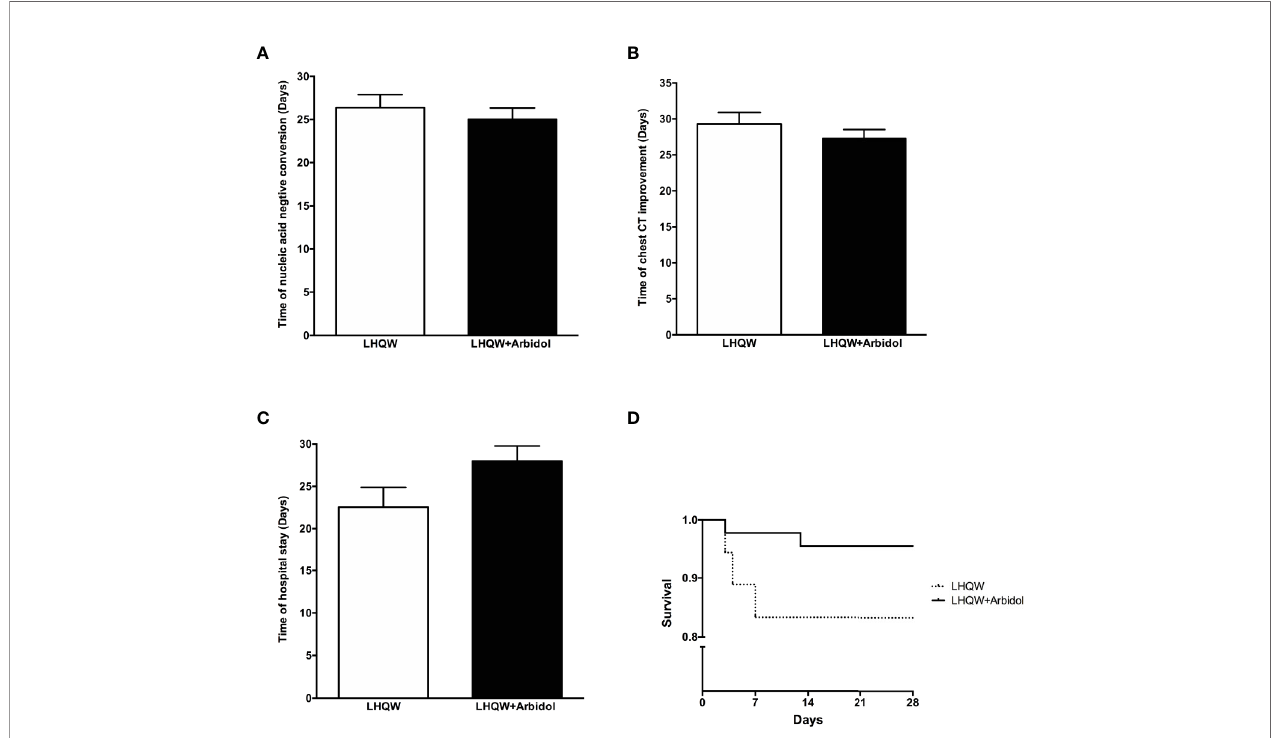
FIGURE 3 | Ef fi cacy of LHQW and LHQW + Arbidol treatment in patients with severe COVID-19. (A) Effect on the time to conversion to nucleic acid negativity. (B) Effect on time to chest CT improvement. (C) Effect on length of hospital stay. (D) Comparison of Kaplan – Meier survival curves in patients with severe COVID-19 treated with LHQW and LHQW +